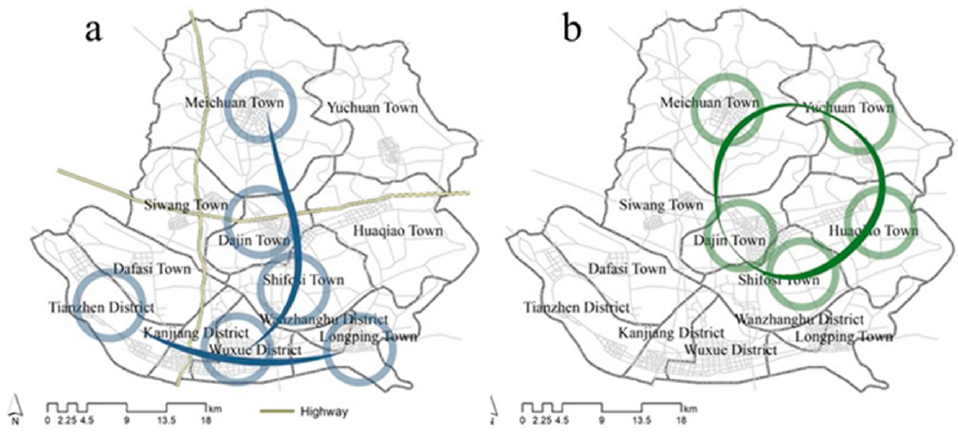
Figure 7. Spatial connection analysis. ( a ) City and town links. ( b ) Town and town links.